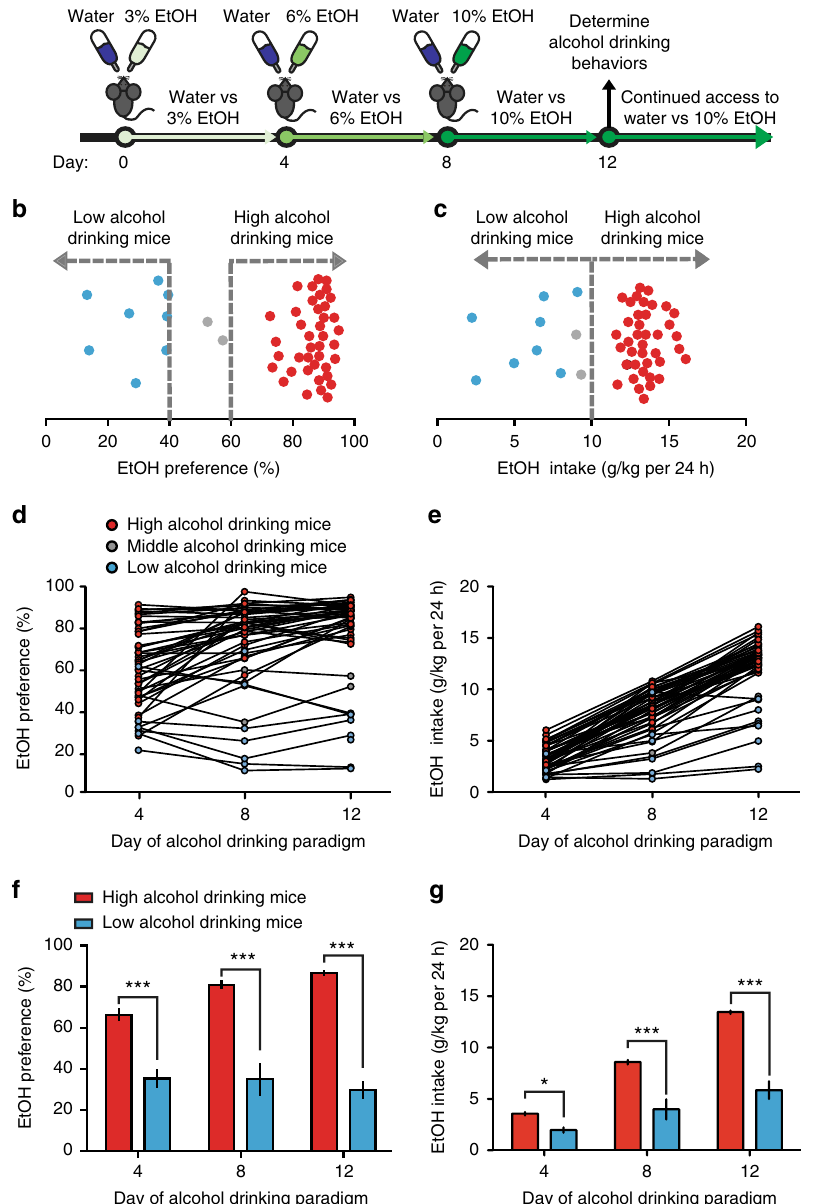
Fig. 1 Individual alcohol drinking behaviors in isogenic C57BL/6J mice. a Individual alcohol drinking behaviors are determined following a continuous access, 12-day, 2-bottle choice alcohol drinking paradigm; mice then have continued access to water or 10% EtOH (v/v) until otherwise noted. b Representative distribution of EtOH preference on 12th day of alcohol drinking paradigm ( n = 50). c Representative distribution of EtOH intake on 12th day of alcohol drinking paradigm ( n = 50). d Individual EtOH preferences plotted across days of alcohol drinking paradigm. Data are EtOH preferences on 4th day of 3% EtOH (day 4), 4th day of 6% EtOH (day 8), and 4th day of 10% EtOH (day 12). e Individual EtOH intakes plotted across days of alcohol drinking paradigm. Data are 24 h EtOH intake behaviors on 4th day of 3% EtOH (day 4), 4th day of 6% EtOH (day 8), and 4th day of 10% EtOH (day 12). f Low and high alcohol drinking group EtOH preferences (two-way RM ANOVA: interaction effect F (2,92) = 12.58, P < 0.001; drinking